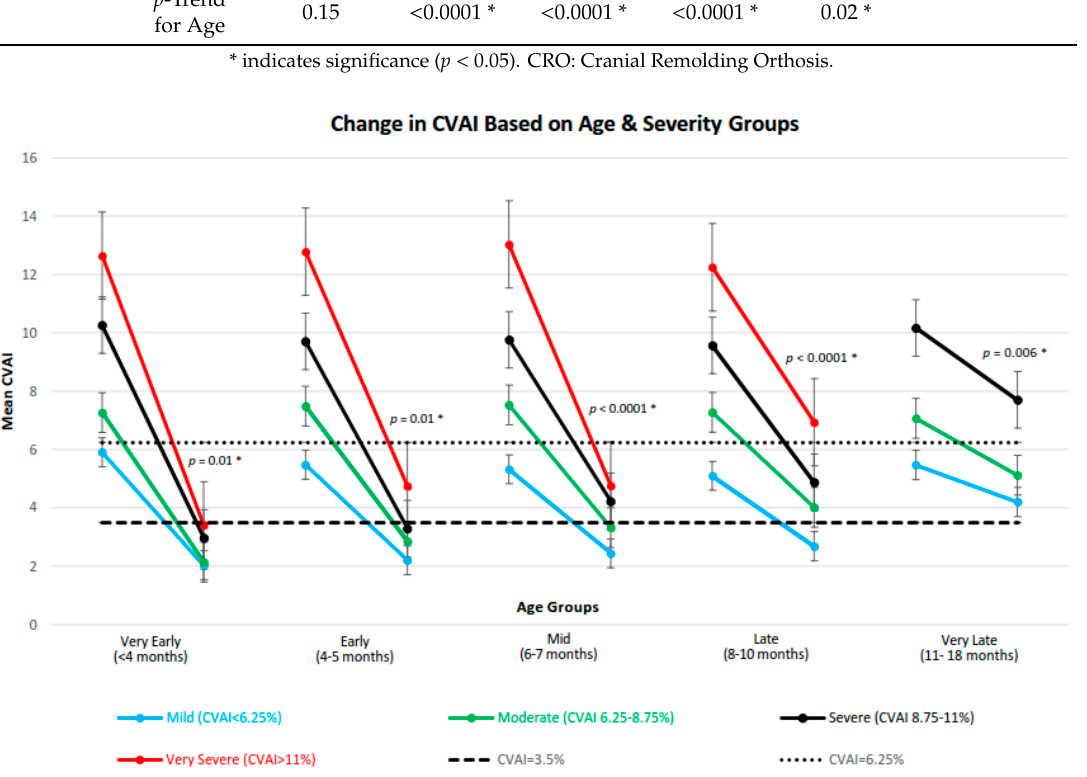
Figure 1. Mean change in CVAI with standard of deviations in CVAI before and after CRO treatment for each subcategory ( n = 499). p -values are from Jonckheere–Terpstra test for trend which shows the trend of final CVAI within severity categories as age increases. CVAI: Cranial Vault Asymmetry Index, CRO: Cranial Remolding Orthosis. * indicates significance ( p <